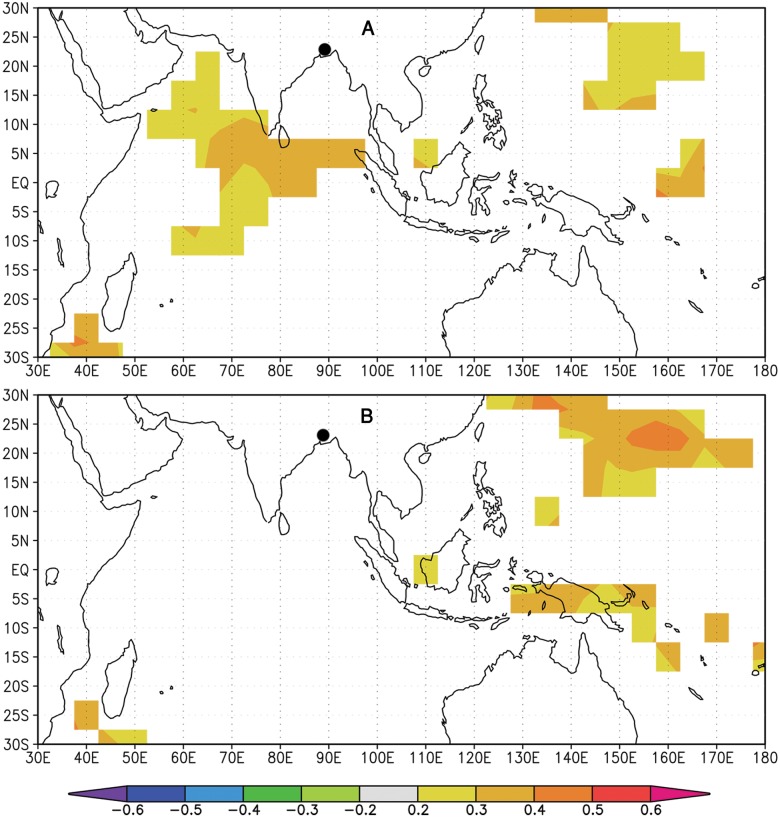
The correlation (1948–2011) between the gridded sea surface temperature (SST; Hadley Centre HadSST3) and precipitation during August–November (A), and September–December (B).Black circle indicates the study area. Orange and red colors indicate positive correlations, and green and blue colors indicate negative correlations (p<0.10). The correlation map was created using the KNMI Climate Explorer (The Royal Netherlands Meteorological Institute; http://climexp.knmi.nl/).